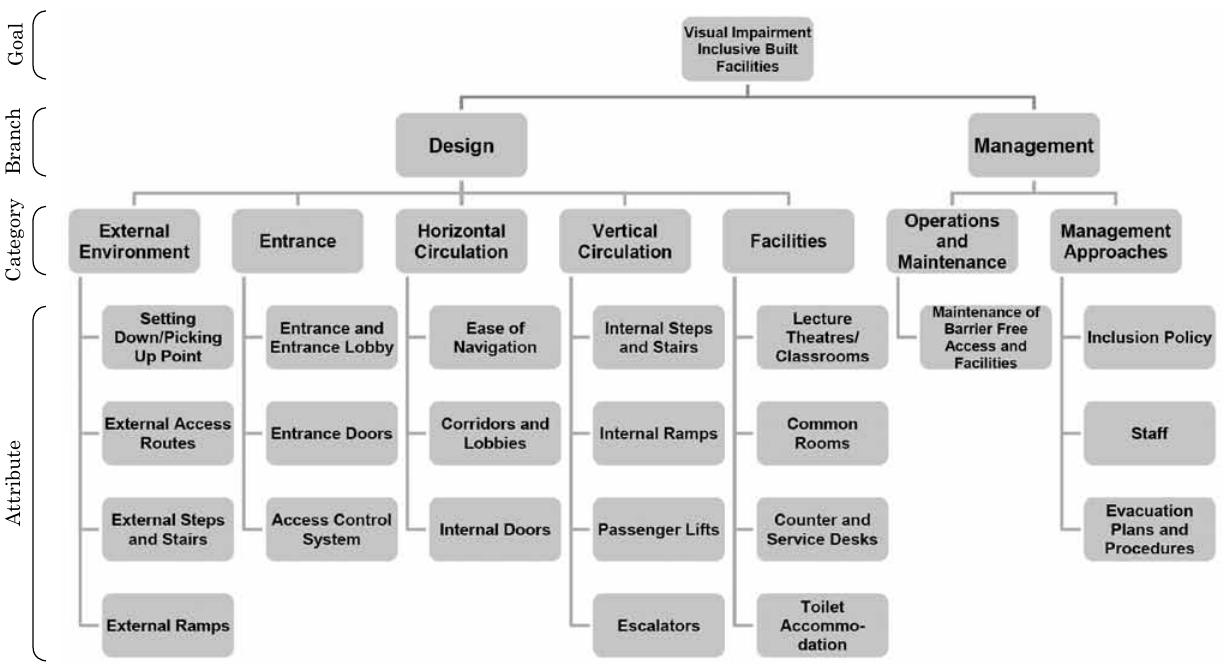
Fig. 2. Hierarchy of assessment attributes in relation to the visual impairment inclusiveness of university